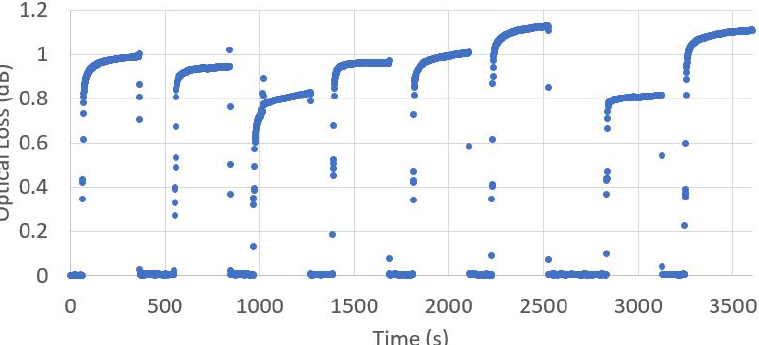
Figure 9. Repeatedly loading and unloading the top surface of an 8 mm radius soft NBR impactor sample, with a 6 kg load. The optical loss of SSMF is shown here as a function of time, where the loading and unloading process was repeated eight times over one